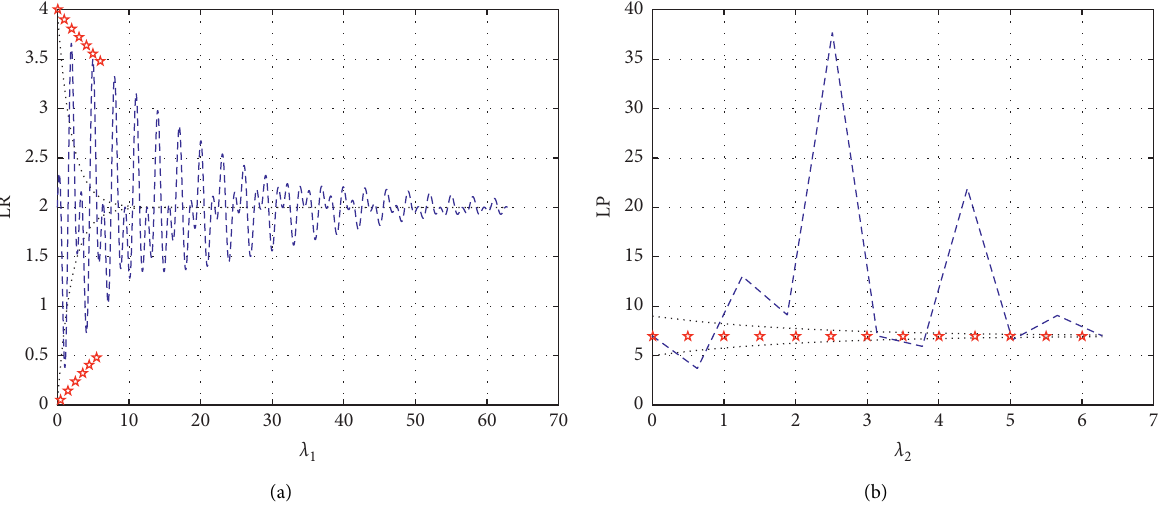
Figure 8: Variation of different λ